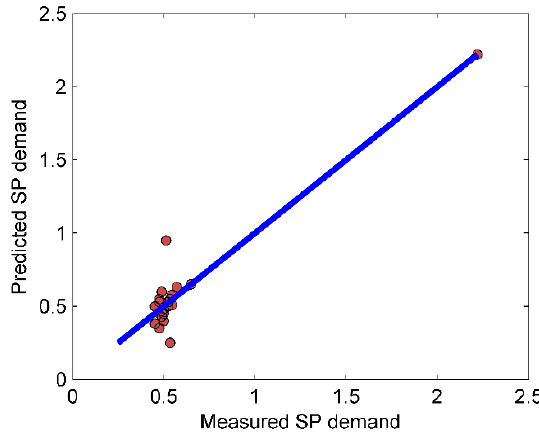
Figure 17. Scatter plot of the SP demand prediction.